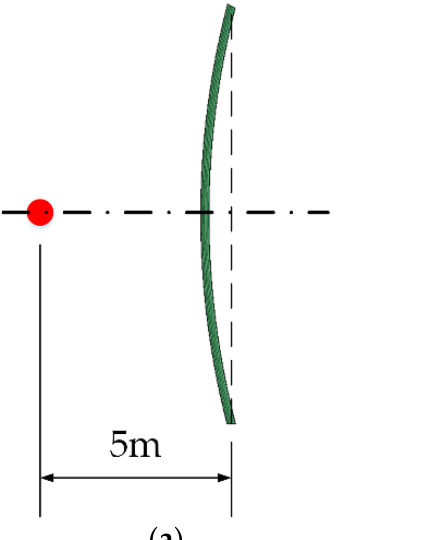
Figure 27. Diagram of TNT position. ( a ) vertical view; and ( b ) left view. Figure 28a,b shows the δ max – k curve and the TEA – k curve of the global blast wall, respectively. It can be seen that with the increase of curvature k , both the energy absorbed by the blast wall and the maximum deflection gradually increases. In addition, the com- prehensive blast resistance index P was calculated according to δ max and TEA , and the result of P shows that when the curvature is 1/20, the value of P is the maximum, which demonstrates that when the curvature is 1/20, the anti-blast performance is the best.